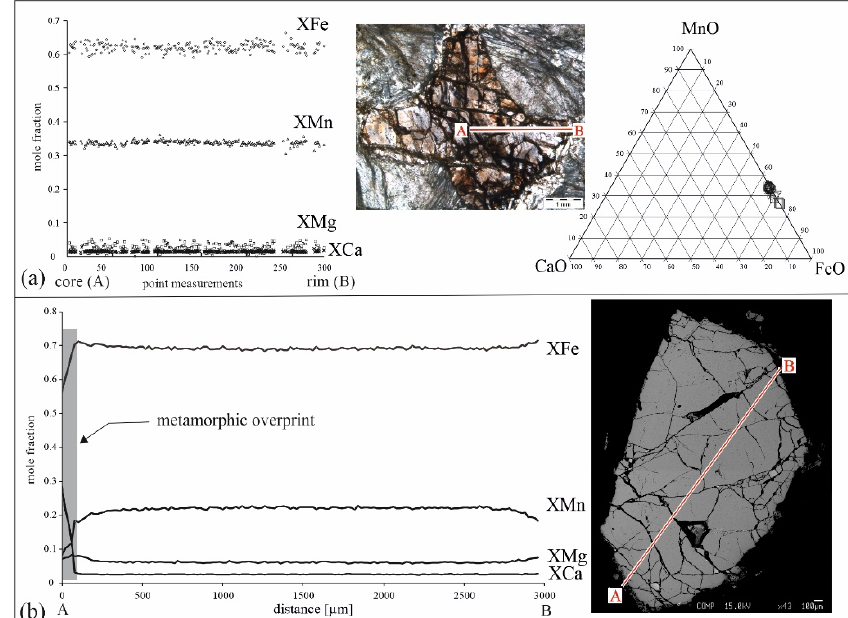
Figure 6. ( a ) Major element composition of a magmatic garnet fragment containing investigated FIs of sample WB01. Left: core (A) to rim (B) major element line profile with a length of ca. 3 mm, corresponding to 300-point analyses. No significant increase in XCa between core and rim exists. Right: major element point measurements in garnet close to domains of studied FI types-A and N in WB01/02. Symbols correspond to different fluid inclusion locations in the studied garnet fragments. ( b ) Major element composition of a big-sized magmatic garnet. Only the outermost 70 μ m have been affected by a metamorphic overprint. Metamorphic overprint is characterized by an increasing trend of XCa (lowermost line) and decreasing trends in XFe and XMn (garnet from sample Kor_3).